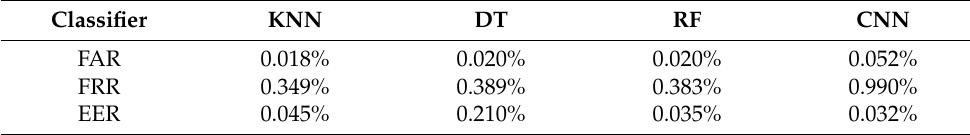
Figure 14. ROC curves for continuous authentication—set of mouse movement and point-and-click actions. Table 12. AD evaluation—Scenario A (single mouse movement action): FAR, FRR, and EER.